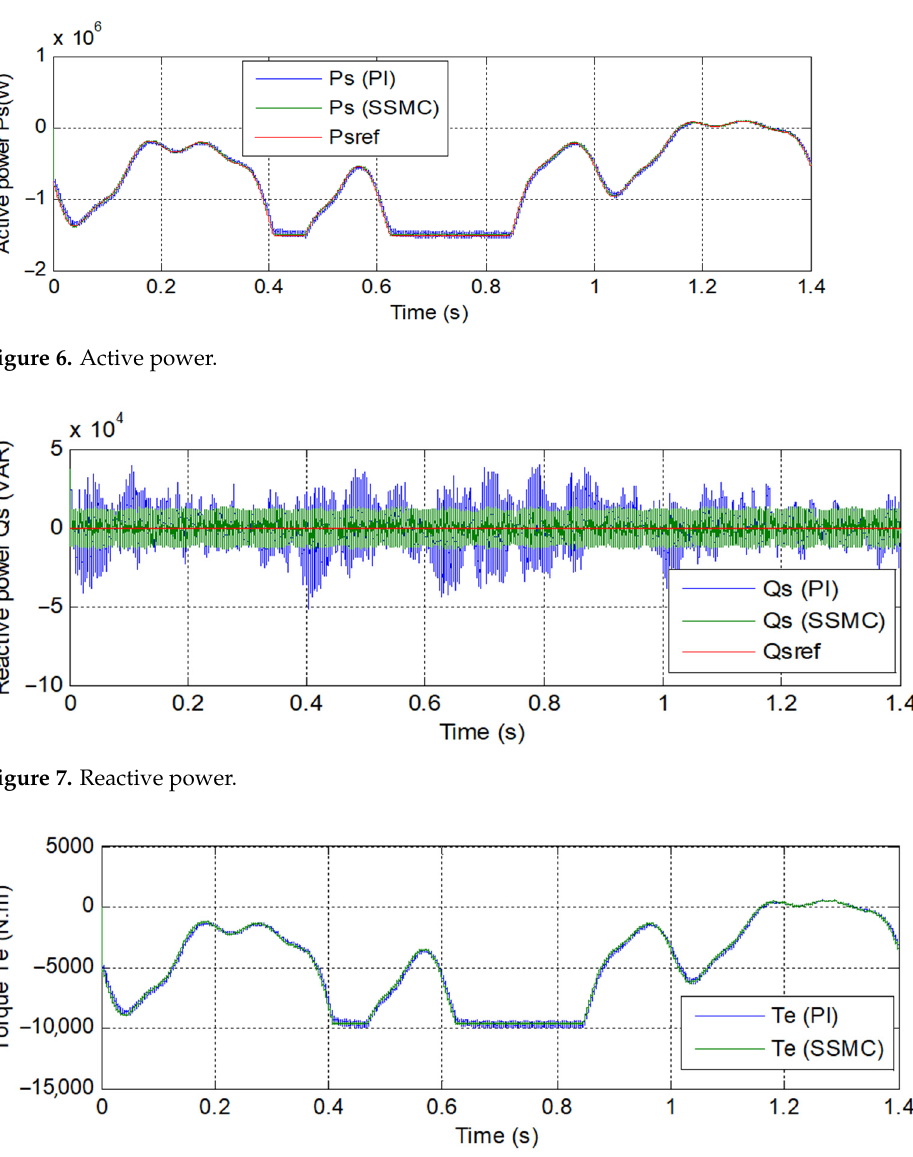
Figure 8. Torque. Figure 8. Figure 8. Torque.